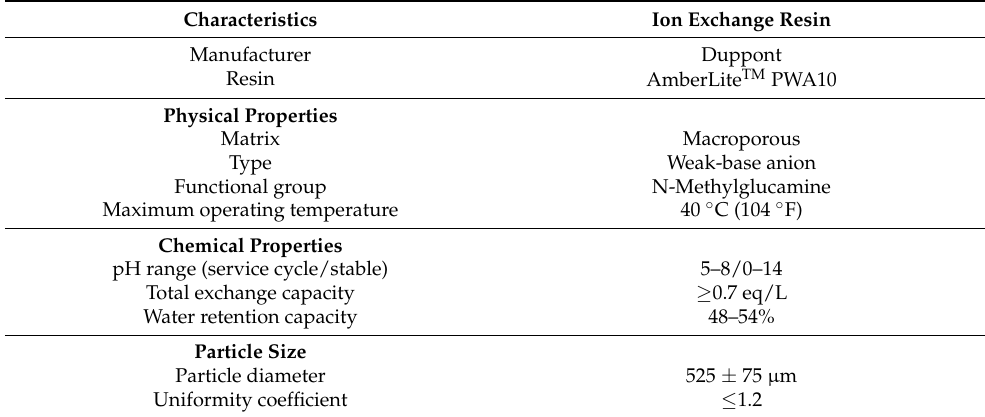
Figure 2. Configuration of experimental on-farm ion exchange system and sampling procedure of the experiment. IX: ion exchange column; T1: HCl tank; T2: NaOH tank. Table 2. Characteristics of the ion exchange resin selected for the trial.